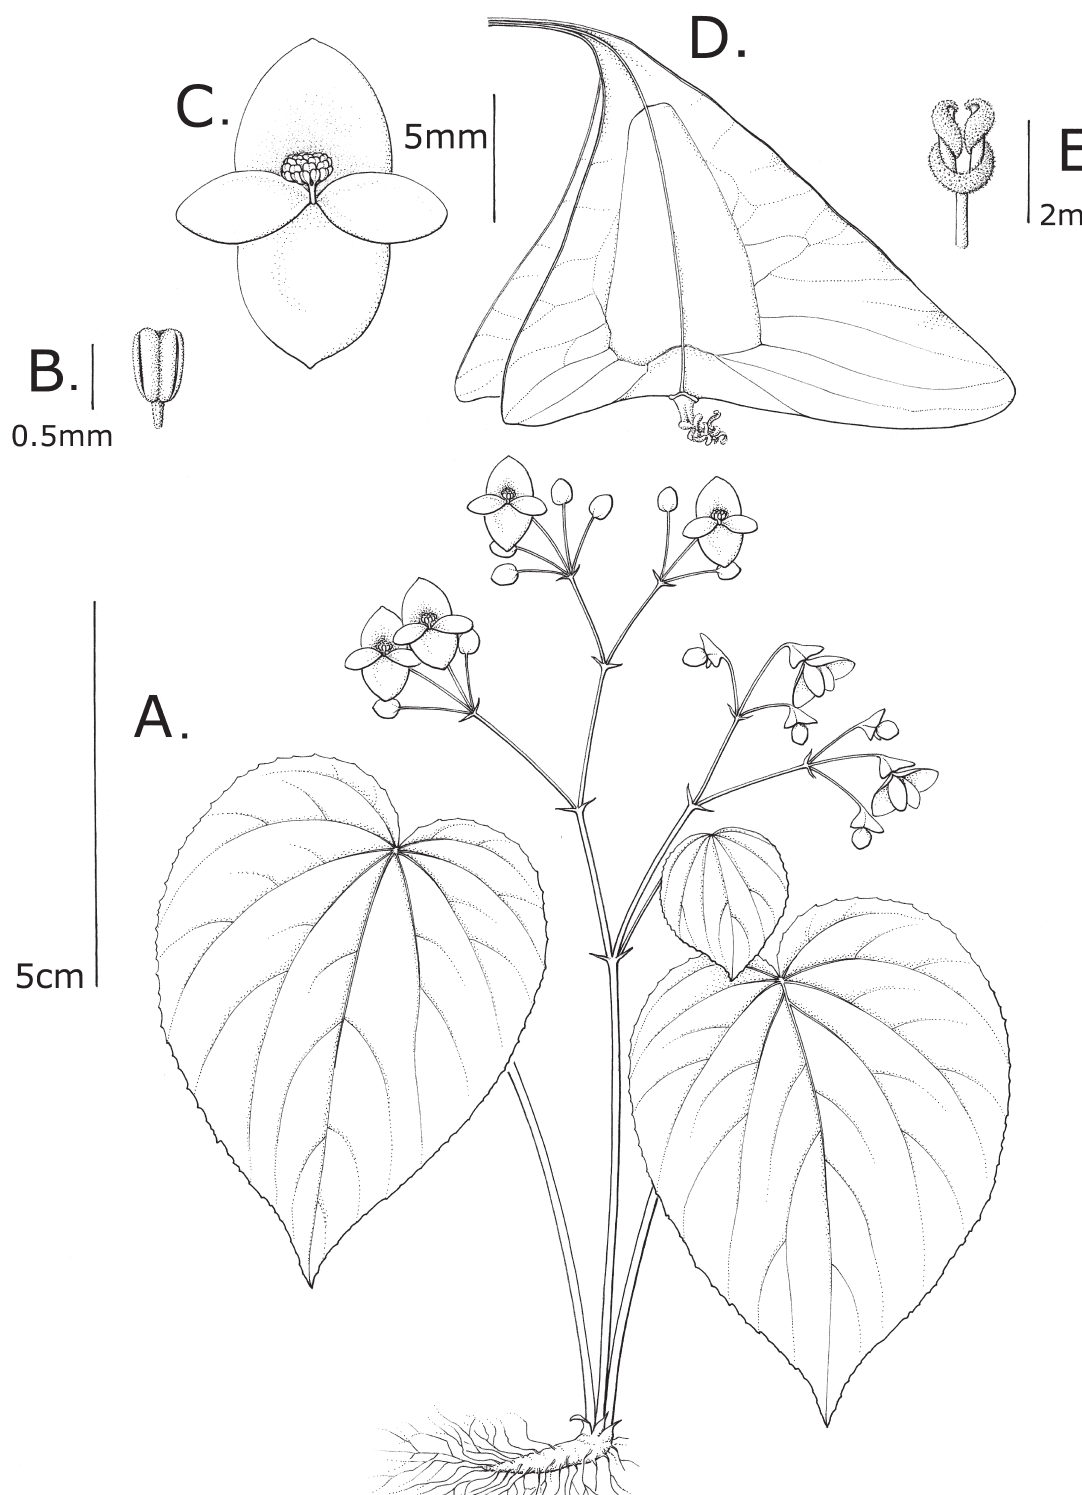
Fig. 44. Illustration of B. ovatifolia A.DC . A . Habit of plant. B . Stamen. C . Male flower. D . Mature fruit. E . Style. Drawn by Claire Banks. A from Parry 731 ; B–C, E from Hooker & Thomson 27 ; D from Clarke 45107A ; all